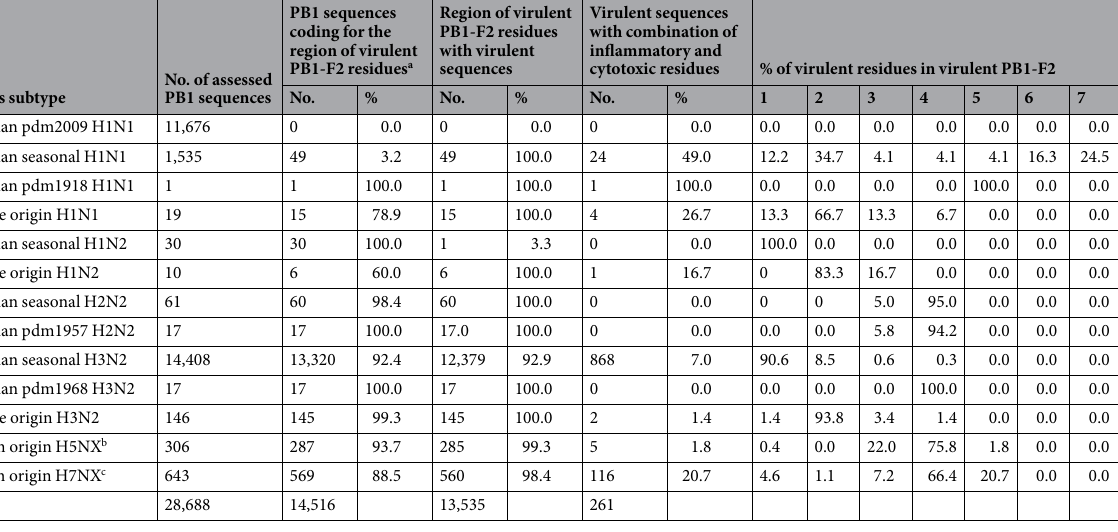
Table 1. Frequency of virulent residues * in PB1-F2 proteins of influenza A viruses isolated from humans. * Inflammatory (L62, R75, R79, and L82) and cytotoxic (I68, L69, and V70) residues (according to PB1-F2 amino acid numbering). a Residues 62–82 (at least 62 residues in length); bH5N1 and H5N6; cH7N2, H7N3, H7N7, and